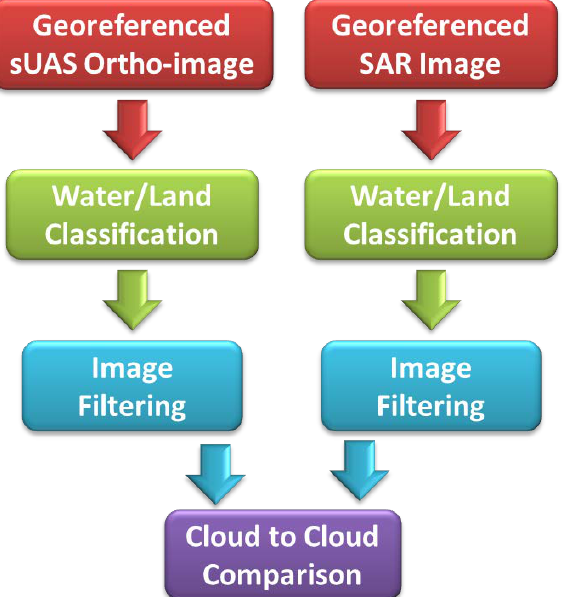
Figure 7. Image processing workflow to validate land/water delineation using RADARSAT-2’s SAR imagery.